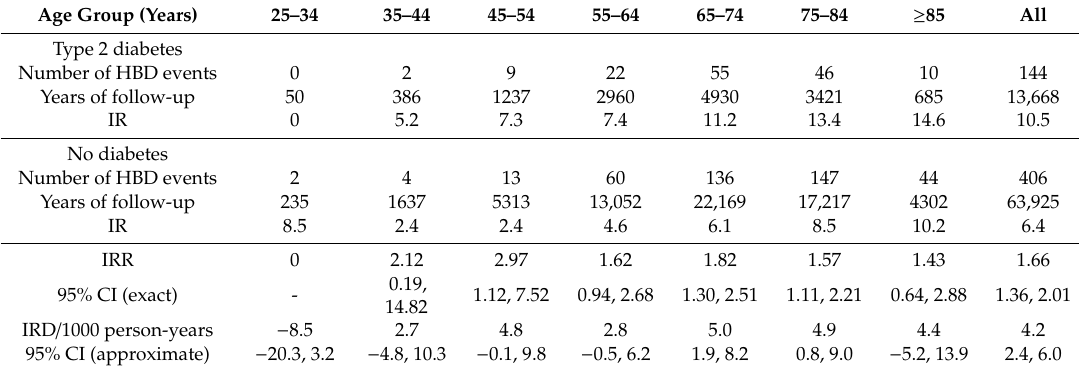
Table 8. Age-specific incidence rates (IRs) per 1000 person-years, incidence rate ratios (IRRs), and incident rate di ff erences (IRDs) for first-ever hospitalization for / with or cancer registration or death from / with hepatobiliary disease (HBD) in the Fremantle Diabetes Study Phase I cohort for type 2 diabetes versus no